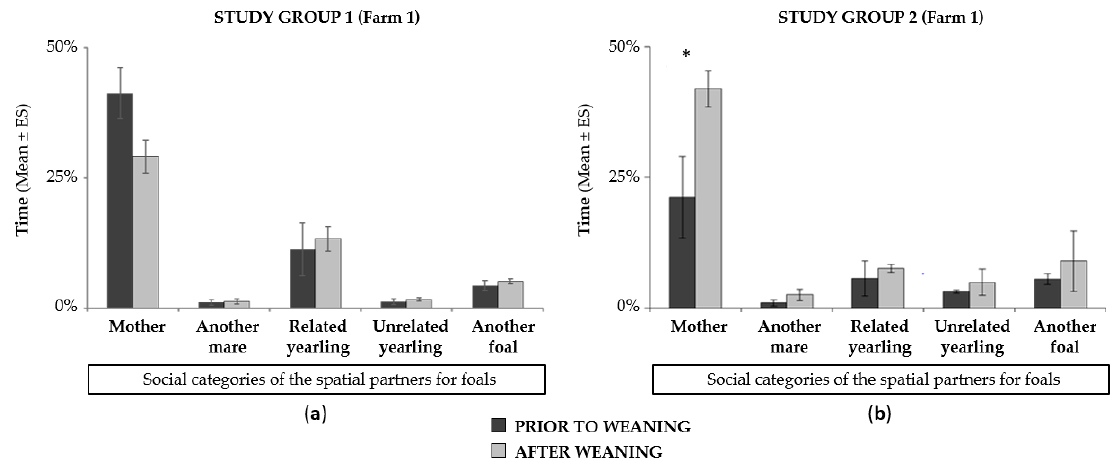
Figure 1. Change in the of mare–foal distance before and after weaning: ( a ) in study group 1; ( b ) in study group 2. Wilcoxon tests: * p < 0.05.